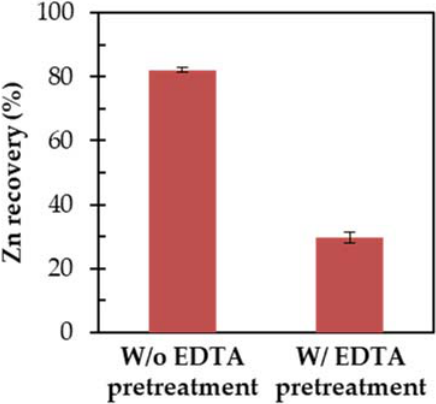
Figure 8. Effects of EDTA pretreatment on the floatability of ZnS in the presence of PbSO 4 .